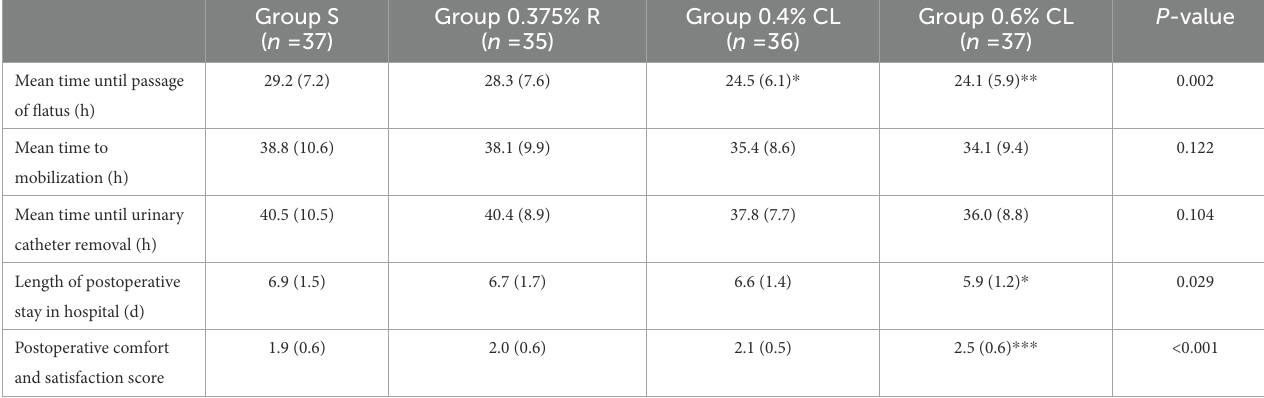
TABLE 3 Postoperative surgical outcomes